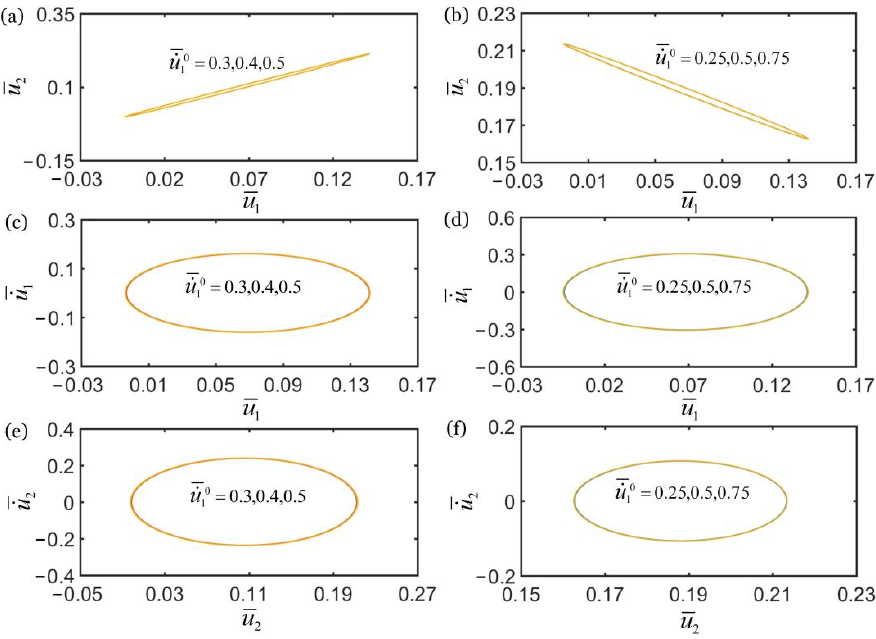
0 . u  on self-oscillations of the two coupled oscillators. ( a ) u 1 1 on self-oscillations of the two coupled oscillators. = k . ( b ) Domain of attraction, 2 = k . In the computation, the other geometric 2 0 . u  does not affect the self-oscil- u 1 does not affect the 1